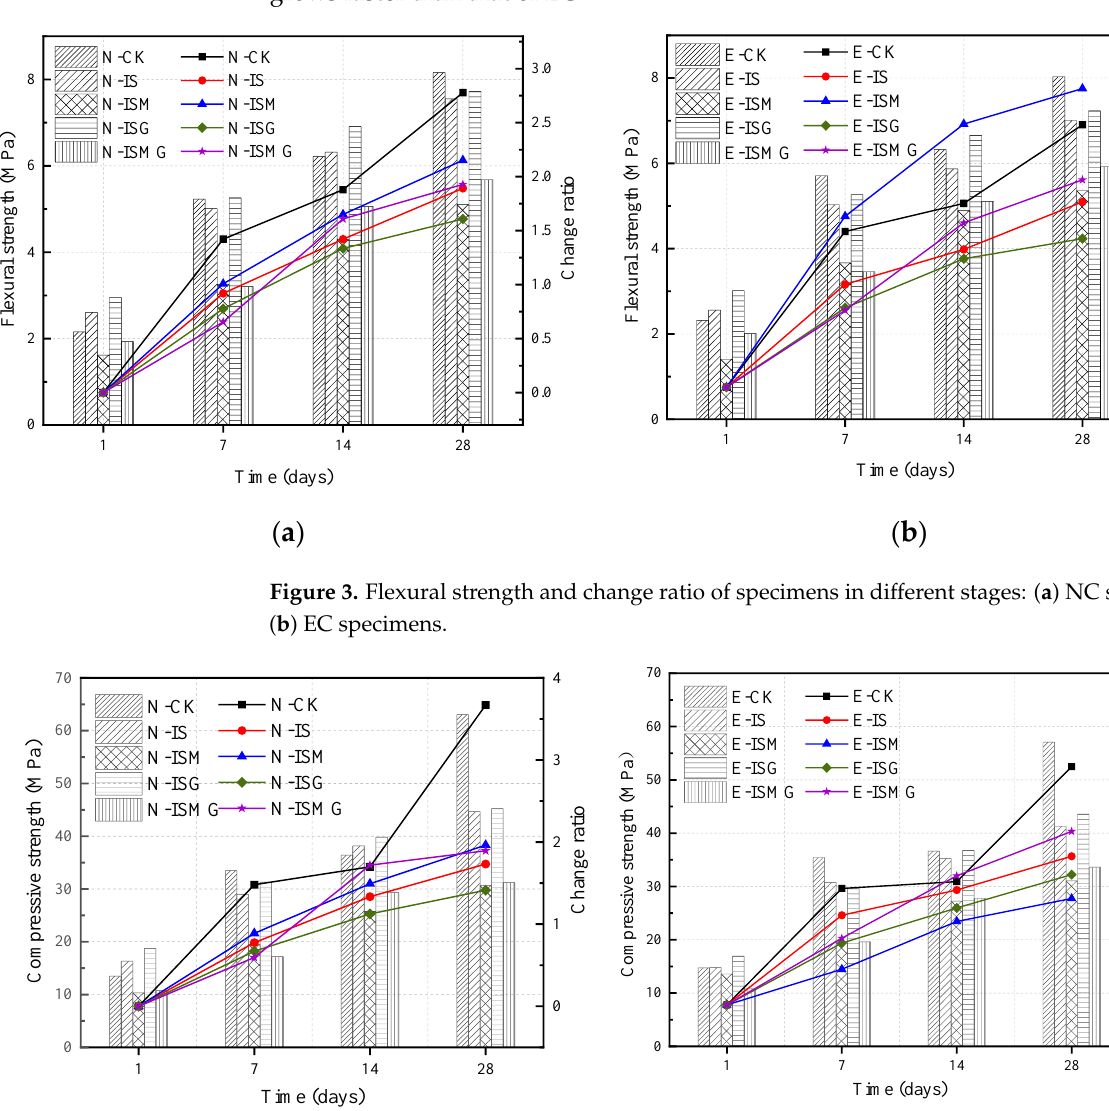
Figure 3. Flexural strength and change ratio of specimens in different stages: ( a ) NC specimens and ( b ) EC specimens.